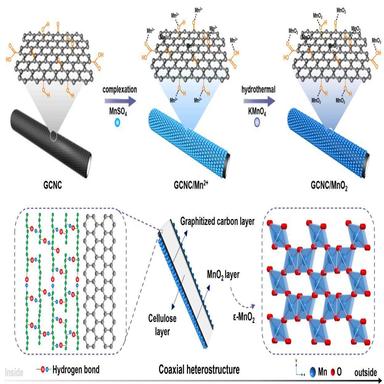
Schematic illustration of the fabrication process of GCNC/MnO2 coaxial heterostructures.